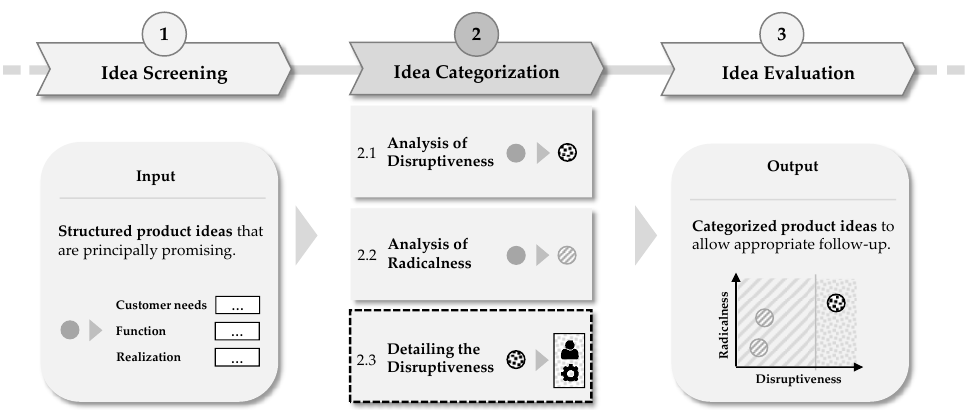
Figure 3. Idea Categorization: Input/output and procedure.